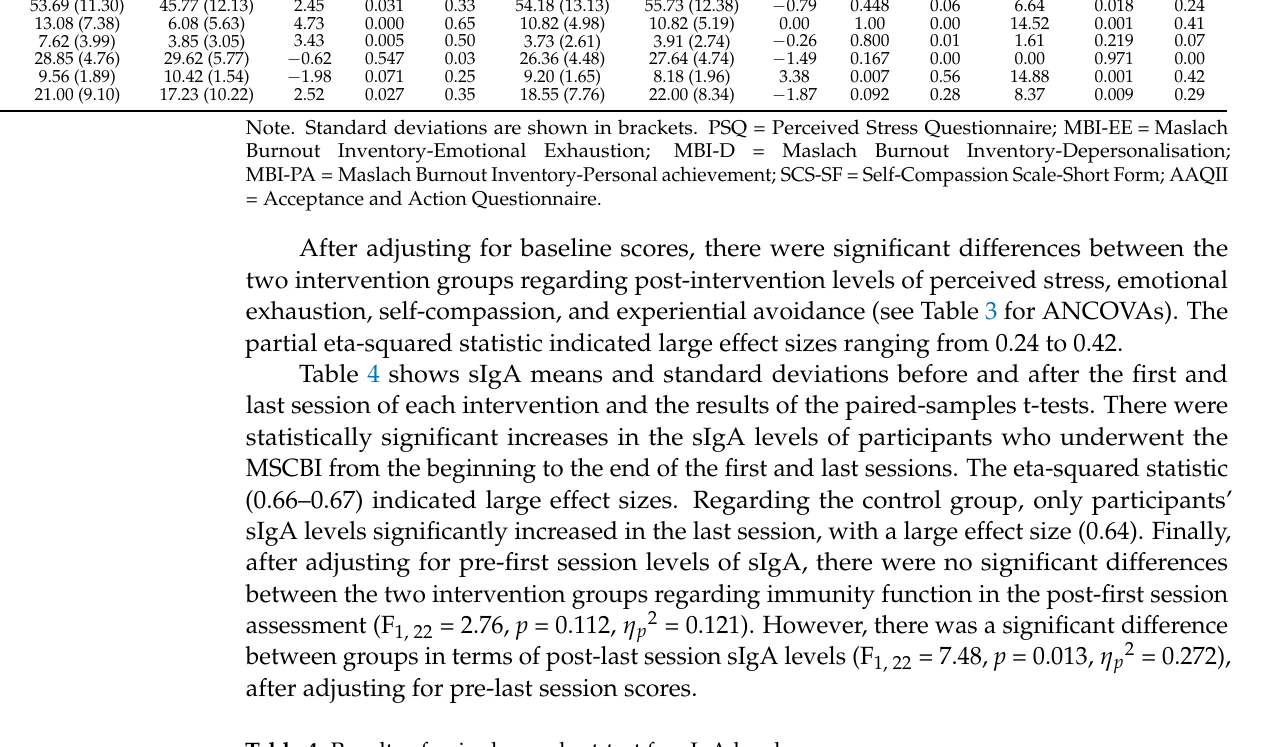
Table 4. Results of paired-samples t-test for sIgA